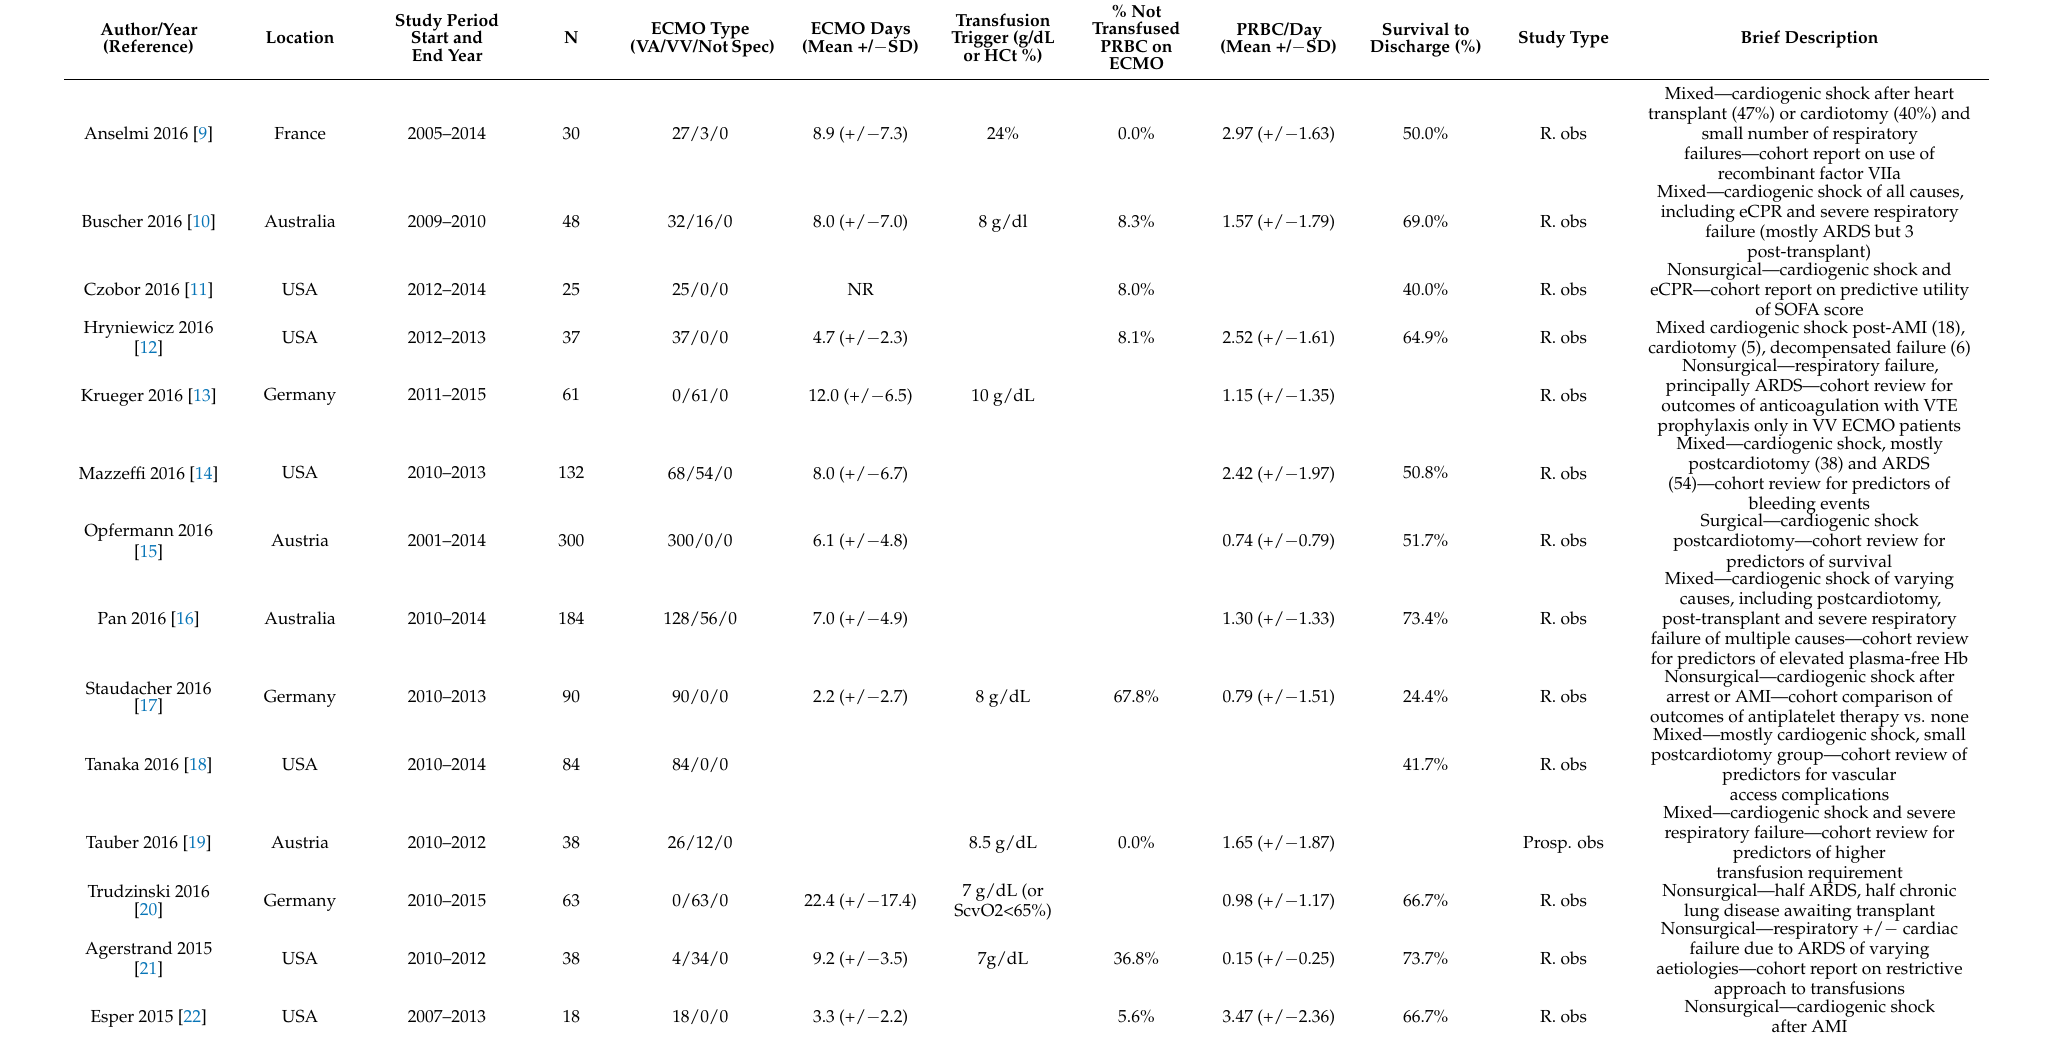
Table 1. Summary of included